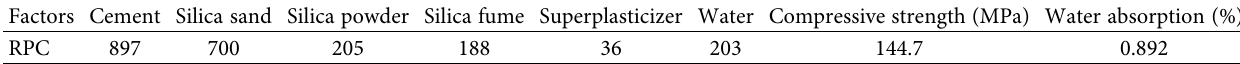
Table 16: Optimal RPC concrete mix design recommended by Minitab for water absorption.